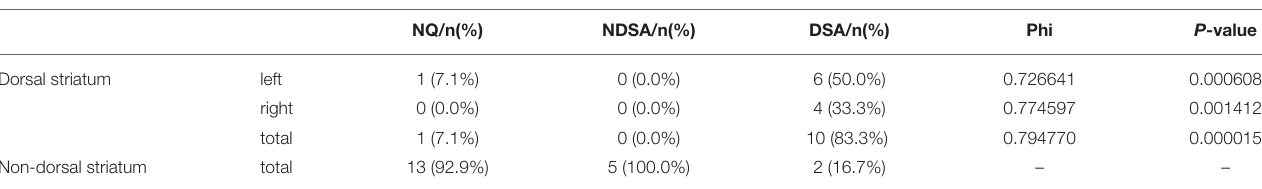
TABLE 3 | Number of participants in different